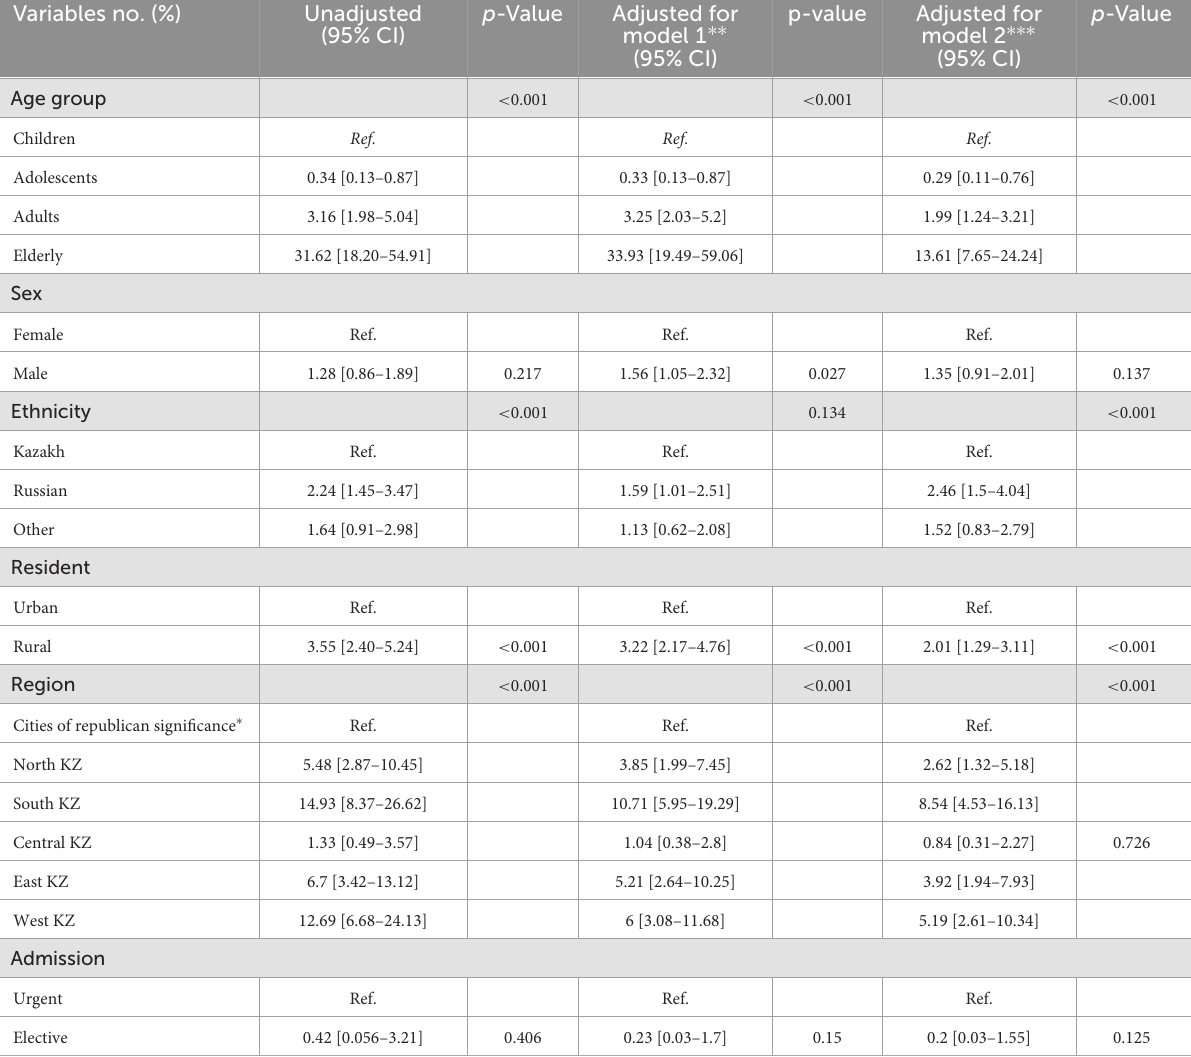
TABLE 2 Multivariable Cox proportional hazards regression analysis with unadjusted and adjusted values over 2014–2019. Variables no.